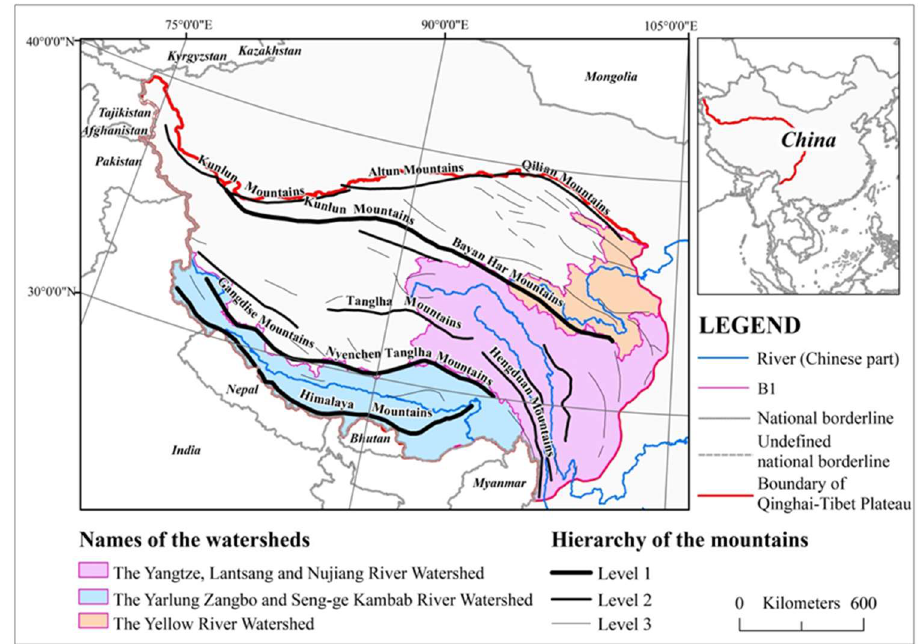
Figure 3. First-level watershed boundaries (B1). (The first-class rivers and high-grade mountains define the basic boundaries of the three dialect areas on the Qinghai–Tibet Plateau of the Chinese part).